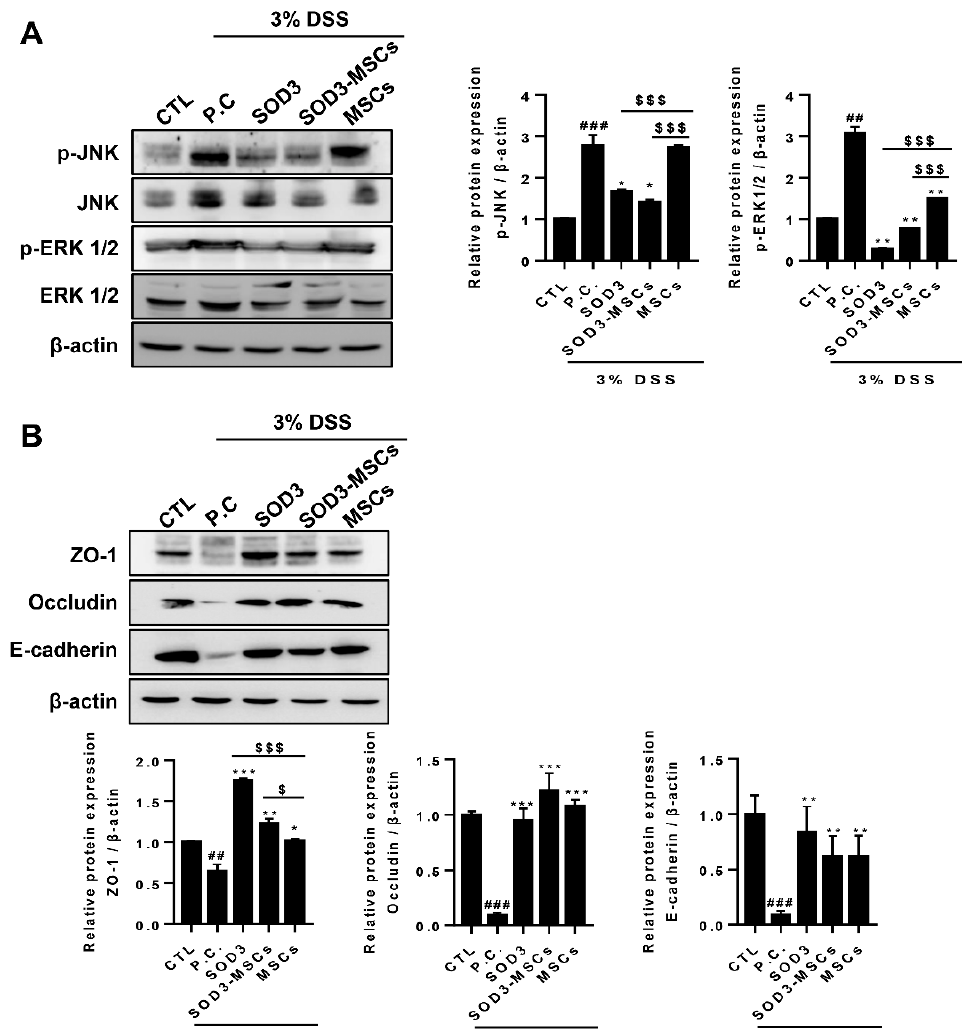
Figure 5. Expression of proteins in MAPK pathway and epithelial junctions in colons of colitis mice. ( A ) p-JNK, JNK, p-ERK1/2, and ERK1/2 were detected by immunoblotting. The expressions of p-JNK and p-ERK1/2 were quantified. ( B ) Expressions of ZO-1, occludin, and E-cadherin were analyzed by immunoblotting and quantified. ## p < 0.01, ### p < 0.001 (CTL vs. P.C), * p < 0.05, ** p < 0.01, *** p < 0.001 (P.C vs. SOD3, SOD3-MSCs and MSCs), $ p < 0.05, $$$ p < 0.001